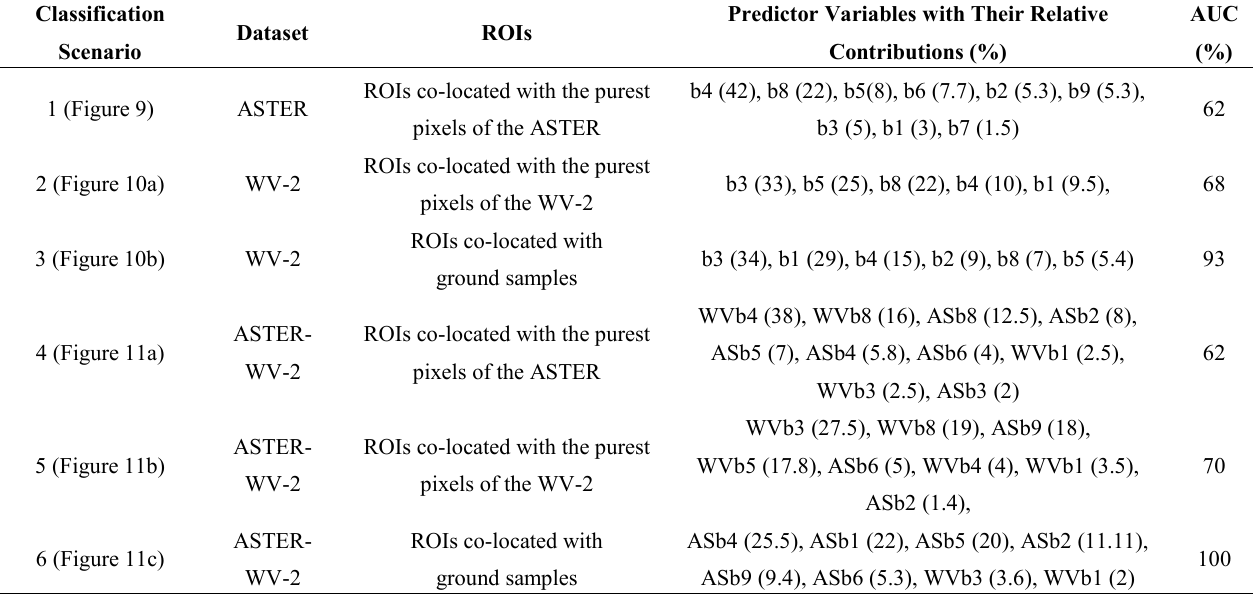
Table 2. Relative contributions (%) of predictor variables and area under curve (AUC) values for the BRT classifications of various